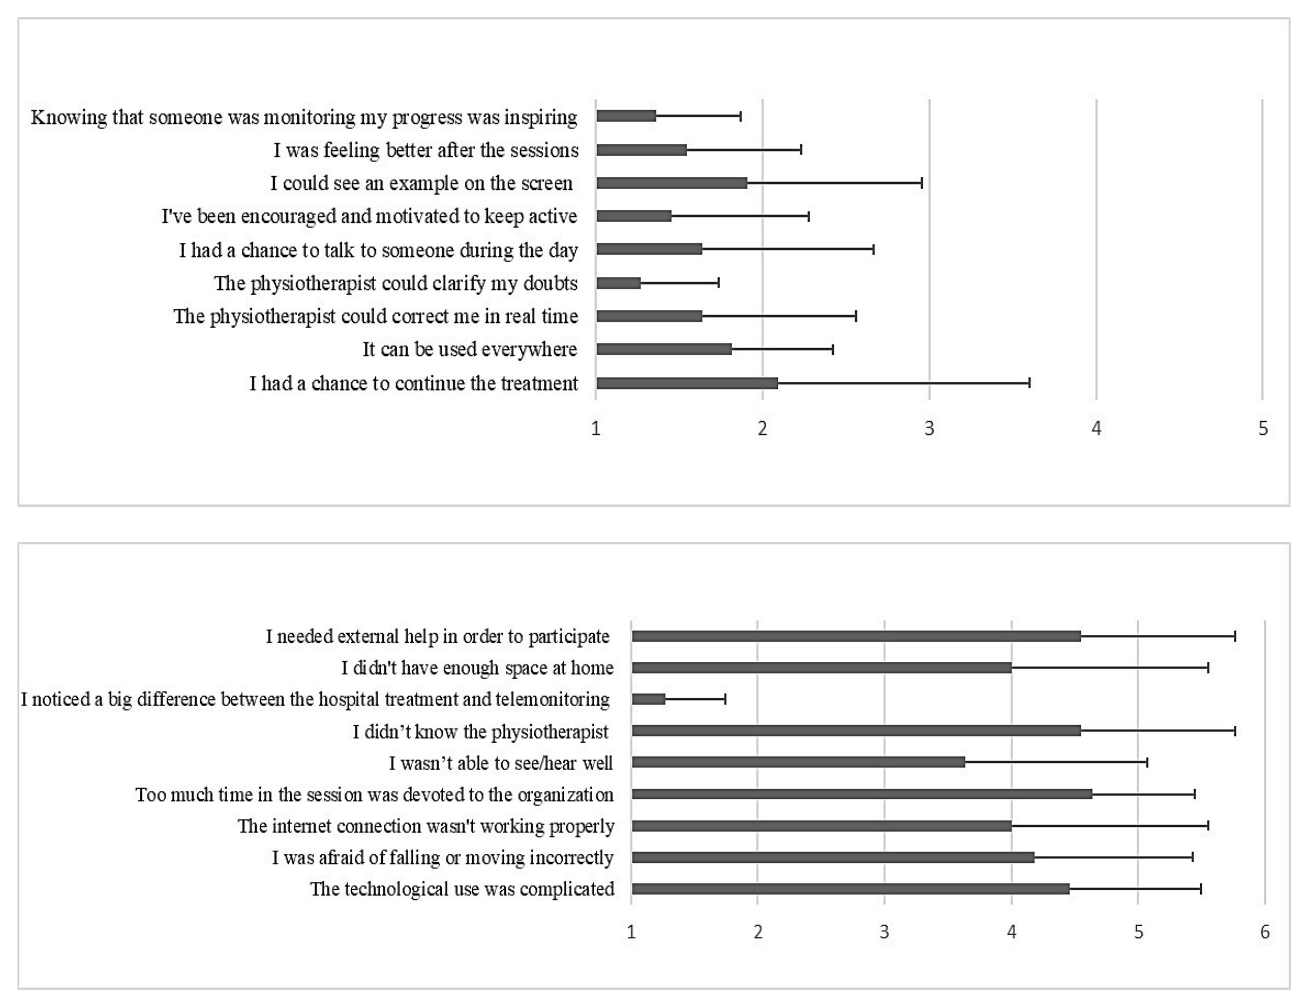
Self-reported Advantages and Disadvantages of Telerehabilitation